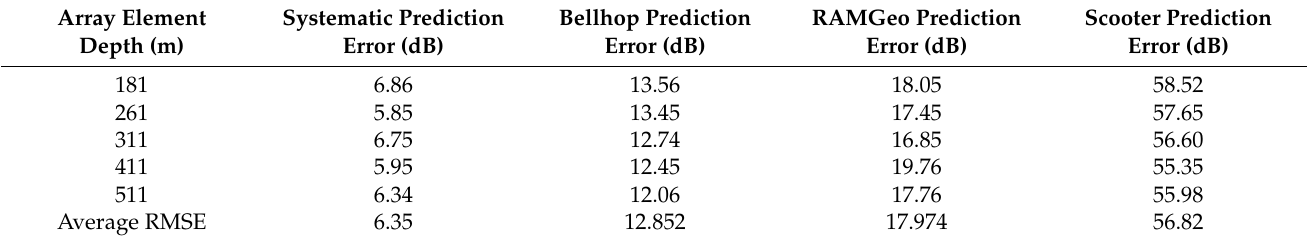
Figure 11. Comparison of system prediction TL and sea trial TL. Table 5. Root Mean Square Error (RMSE) error comparison (245